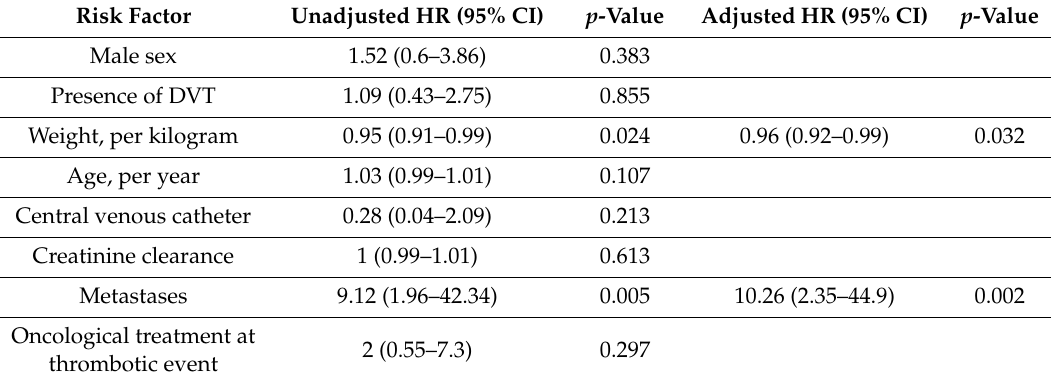
Table 3. Unadjusted and adjusted hazard ratios for overall mortality in patients with incidental pulmonary